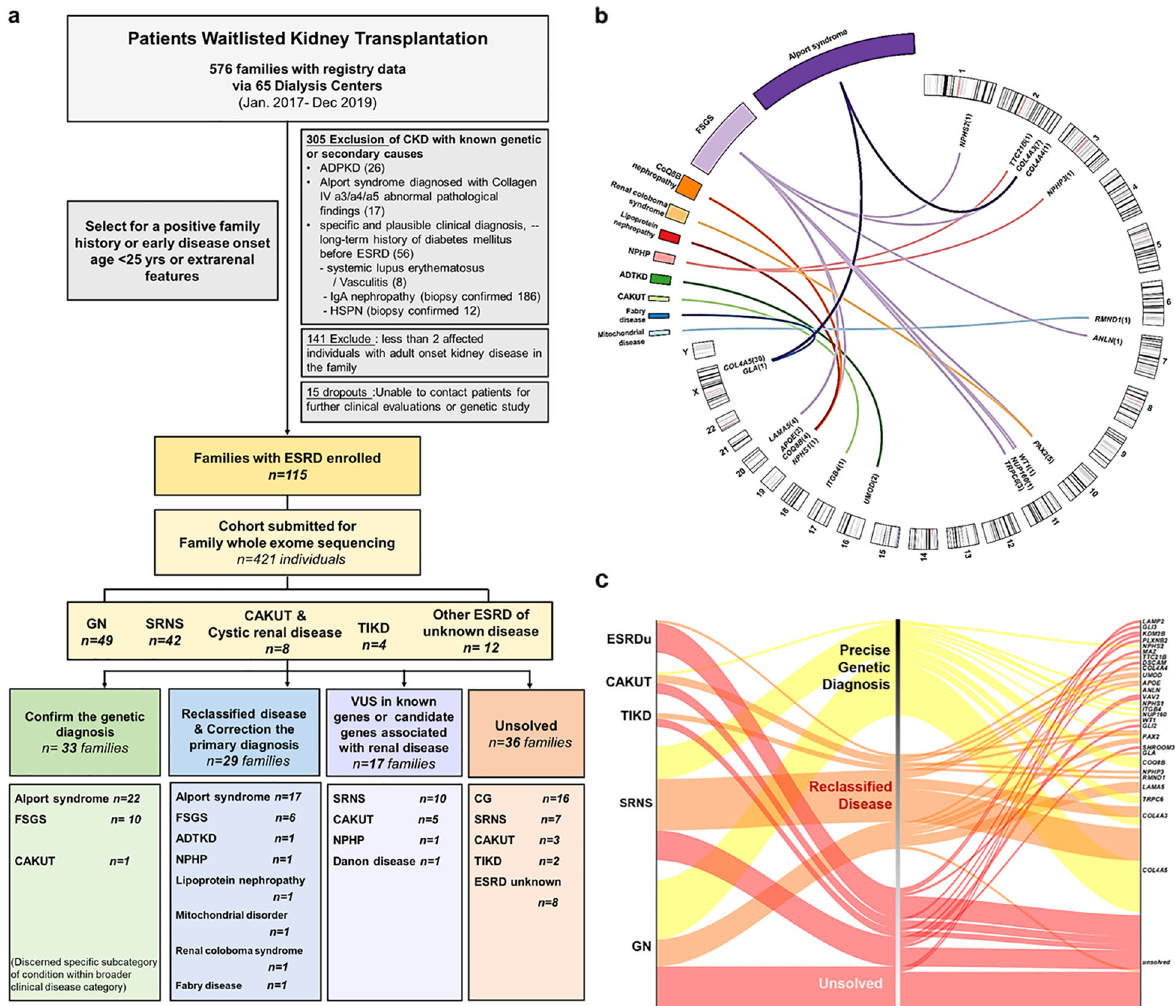
Fig. 1 Genetic fi ndings post exome sequencing (ES) study in families on the waitlist for renal transplantation. a Study design and strati fi cation. Through evaluation of the registry information in the waiting list for transplantation, patients with a positive family history or patients with clinical suspicion of a genetic kidney disease owing to childhood early onset or extrarenal features were enrolled into the study. All the recruited families ( n = 115) with ESRD were divided into fi ve subgroups according to the prior clinical diagnosis of renal disease. ES was performed in 421 individuals from the 115 families (226 patients with CKD). Family-ES identi fi ed a speci fi c underlying cause within the broader category of clinical suspected disease in 33 families, modi fi ed or reclassi fi ed the clinical diagnosis in 27 families, and established a diagnosis in two families referred with ESRD of unknown origin. In 17 families, we detective promising variants of uncertain signi fi cance (VUS) in candidate genes associated with renal development. b Circos-style plot of genetic diagnosis in 62 families of ESRD. Ten categories of kidney diseases are indicated outside the widest arc of the circle, chromosome numbers are labeled outside the smaller arc, and gene symbols with patient numbers (patients with pathogenic or likely pathogenic variants) are listed inside. Links are colored by ten categories. c From clinical diagnosis to genetic diagnosis for renal disease based on ES study in 115 families. Left and middle: division of the priori clinical diagnosis and change in fi nal diagnosis. Middle and right: division of change in fi nal diagnosis and genetic fi ndings (pathogenic, likely pathogenic variants, and VUS). The width of the lines in the Sankey plot is proportional to the relative quantity of families within each group. ADTKD autosomal dominant tubulointerstitial kidney disease, CAKUT congenital anomalies of the kidney and urinary tract, ESRD end-stage renal disease,